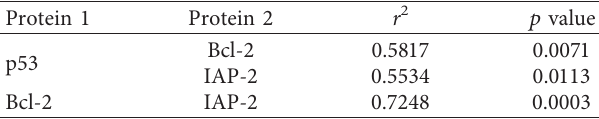
Table 3: Spearman correlation test positive in the area of protein labelling in ameloblastoma.